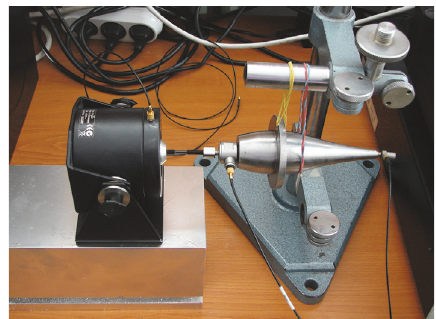
Figure 10: The modal testing setup.